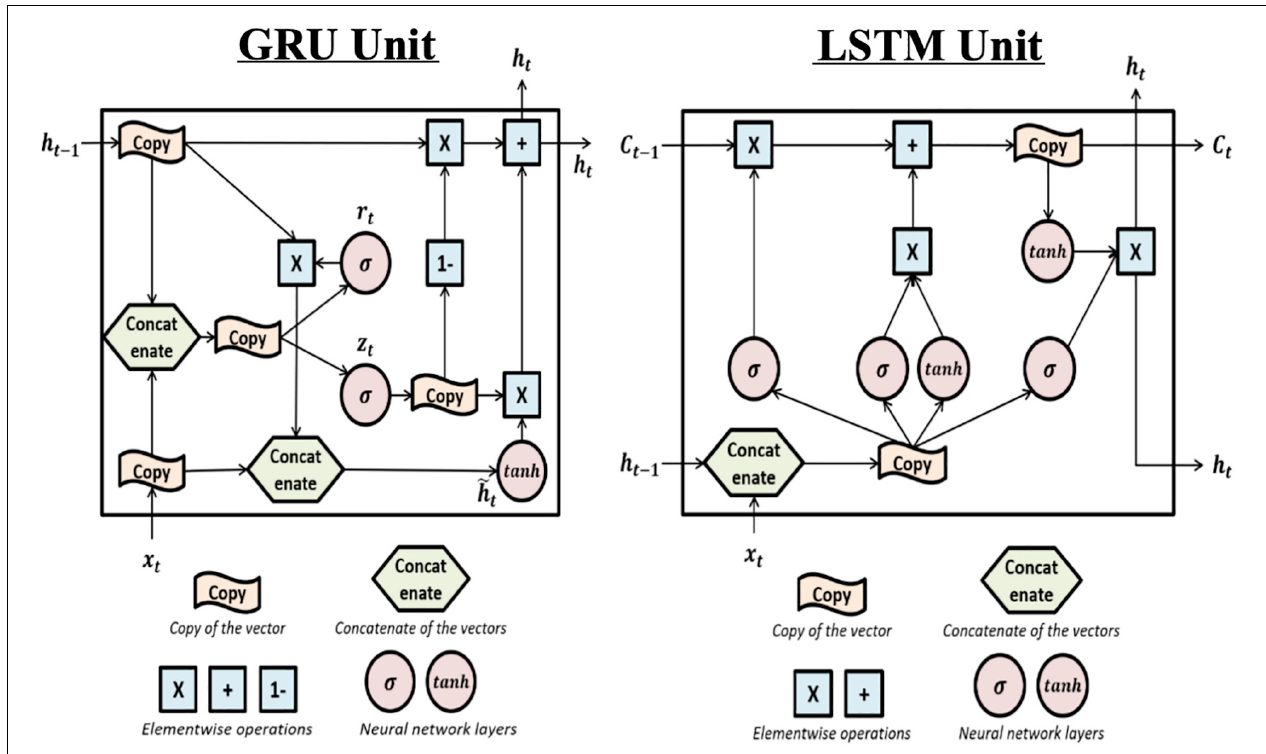
FIGURE 4 | The structure of Gated Recurrent Unit and Long Short-Term Memory units: Left: this is the structure of the Gated Recurrent Unit (GRU). The “update gate” z t is used to determine if the update ˜ h t will be applied to h t . r t is the “reset gate” and is used to determine if the previous hidden value (also the output value) h t - 1 will be kept in the memory. The effects of the two gates are achieved by sigmoid activation functions which can be learned during training. Right: The structure of the Long Short-Term Memory (LSTM) unit. LSTM is complex and includes one more hidden value C t and more gates compared to GRU. Each gate can be seen in the plot where the σ sign appears (i.e., sigmoid activation function). The first σ is the “forget gate” which controls whether previous hidden value, C t - v will be used to calculate current output and kept in the memory. The second σ is the “input gate” which controls whether the new input will be used to calculate current output. The third σ is the “output gate” which filters the output, i.e., controls what part of the output values to send out as h t